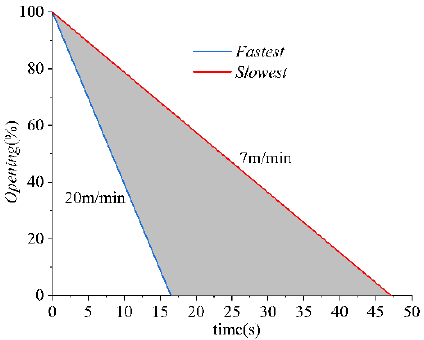
Figure 4. The allowable range of SG speed required by the pump station.